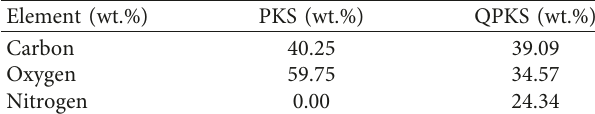
Table 2: EDX analysis of PKS and QPKS. Element (wt.%)